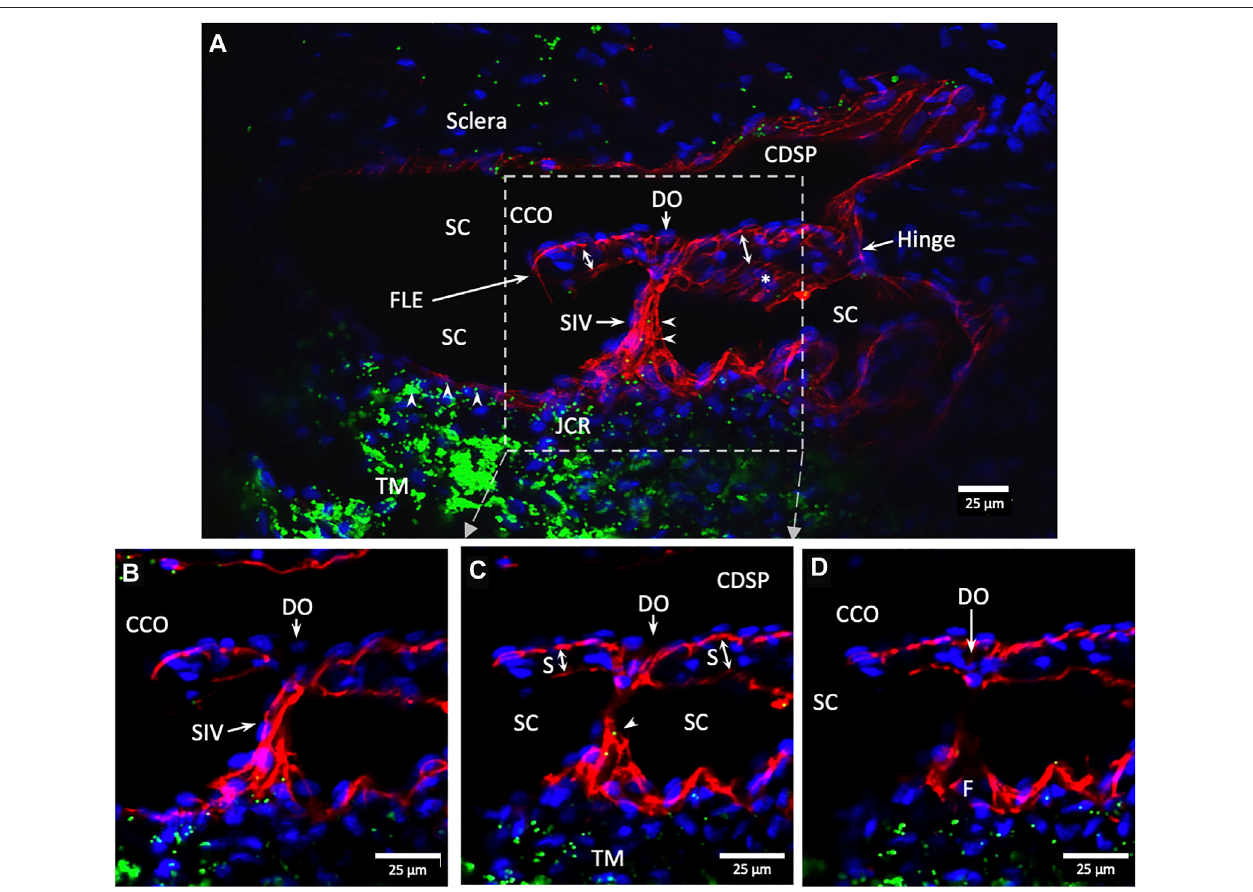
FIGURE 10 | Conduit connects the juxtacanalicular region to collector channel ostia and its hinged fl ap. Merged CD31 (red), DAPI (blue), and 1-µm fl uorescent microsphere (green) channels. (A) This 3D stack is 15 µm. A funnel-shaped region of the inner wall of Schlemm ’ s canal (SC) narrows to form an SC inlet valve-like structure(SIV).TheSIVspansacrossSCandattachestoaseptum(S)(doublearrows).ThisseptumhasanunattachededgeataCC.Inthecrosssection,itappearsasa fl ap-like extension (FLE). The FLE is hinged at its scleral attachment. In this preparation, the open con fi guration of the collector channel ostia (CCO) provides communication between SC, CCO, SIV distal opening, and a circumferential deep scleral plexus (CDSP). The hinged fl ap can open or close, enabling it to function as a SC outlet valve. Green fl uorescent microspheres (indented arrowheads) are at the SC internal wall, aggregate in the juxtacanalicular region, and are present in the SIV lumen. (B – D) represent the boxed area indicated in (A) . Serial non-stacked Z-axis images reveal that the SIV contains a continuous lumen extending from the juxtacanalicular region (JCR) across SC, passing directly through a septum where a distal opening (DO) enters the region of a (CCO). Asterisk indicates an outline of parallel endothelial cells on the undersurface of a septum. TM — trabecular meshwork and (F) — funnel-shaped region Supplementary Video S3 #40RIT13.